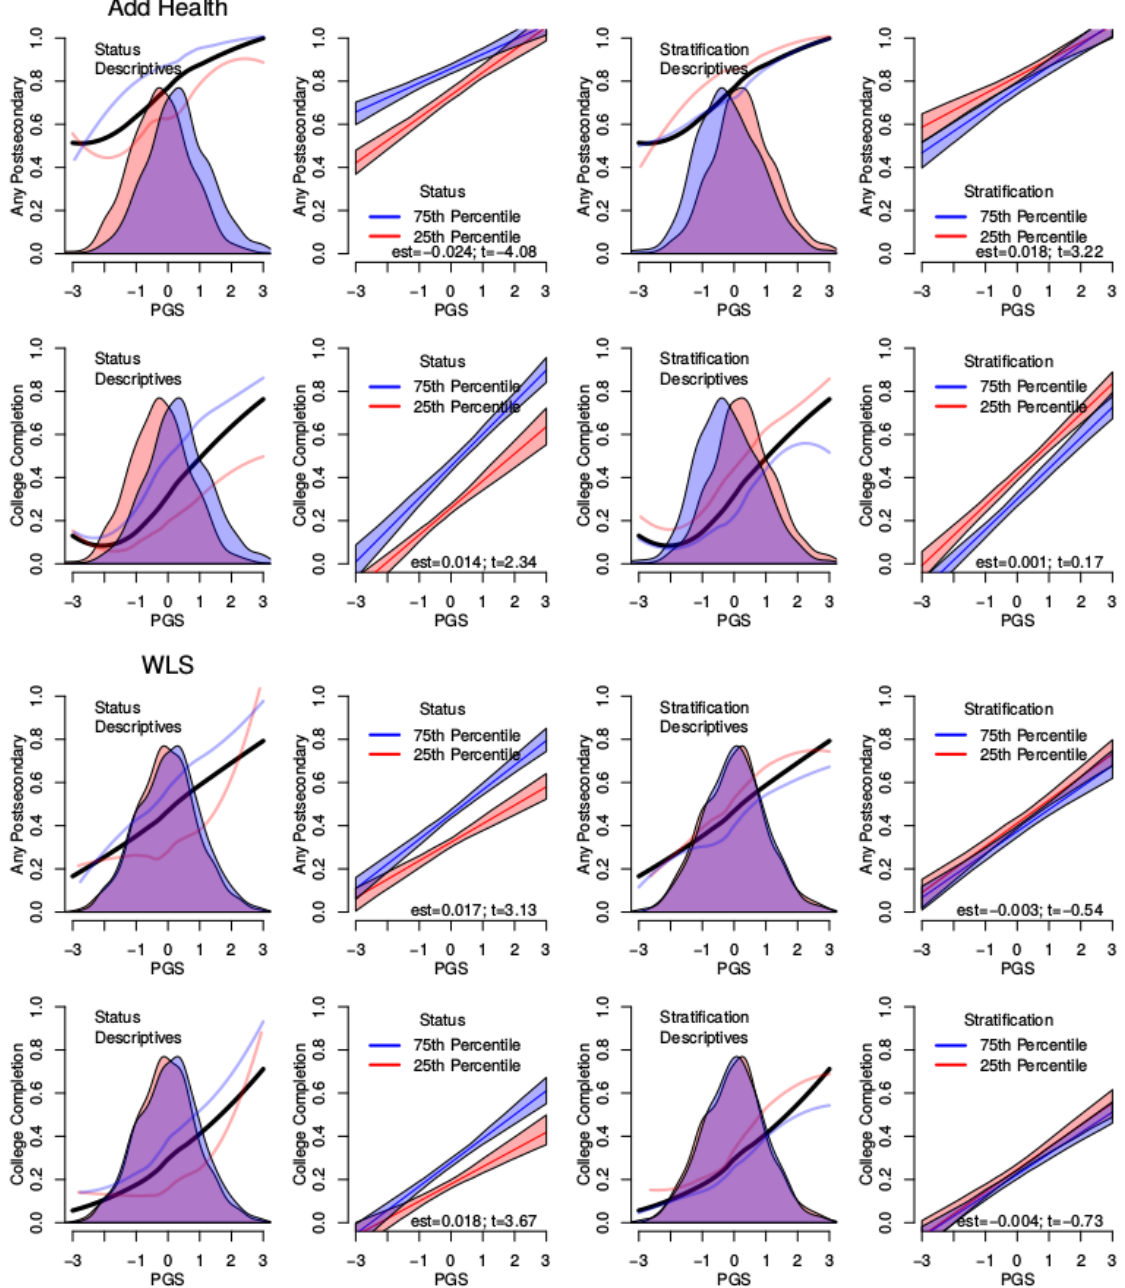
Figure 6: Prototypical plots for direct tests of GxE with candidate environments. Environments are at the 25th and 75th percentiles of the school-level distribution. Results are for females of a mean age (in the WLS, they are also assumed to be graduate respondents). Descriptive panels show distributions (shaded) for students in schools below the 25th percentile and above the 75th percentile (red and blue, respectively). LOESS curves plot fitted probabilities as a function of the PGS for all respondents (black) and those in schools captured in the density plot of same color. est, estimate; PGS, polygenic score; WLS, Wisconsin Longitudinal Study. sociological science |